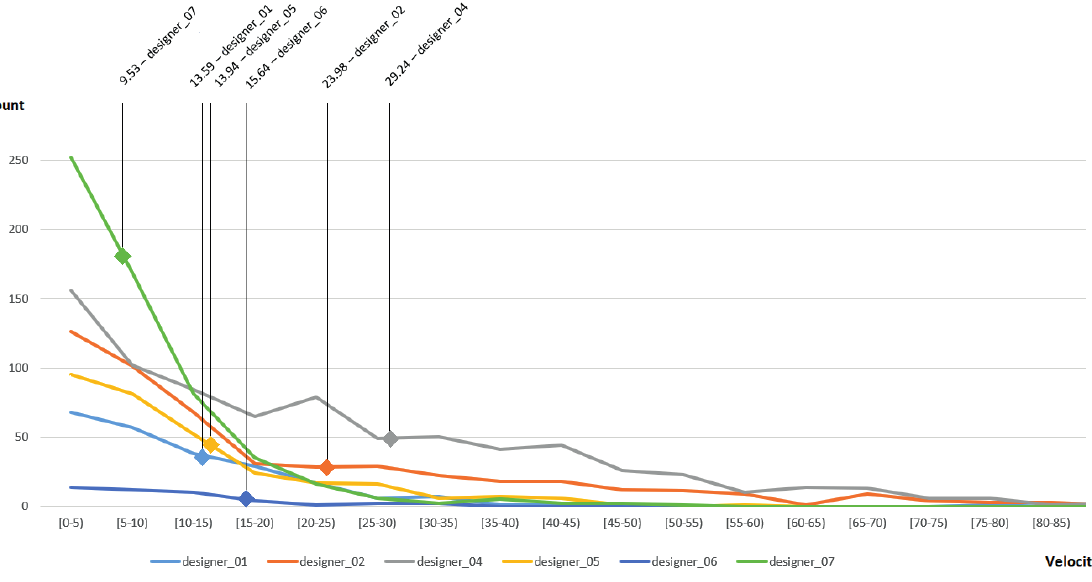
Fig. 6. Distribution of all collected velocities for each designer and the corresponding normalize d expected values of the designer’s velocity